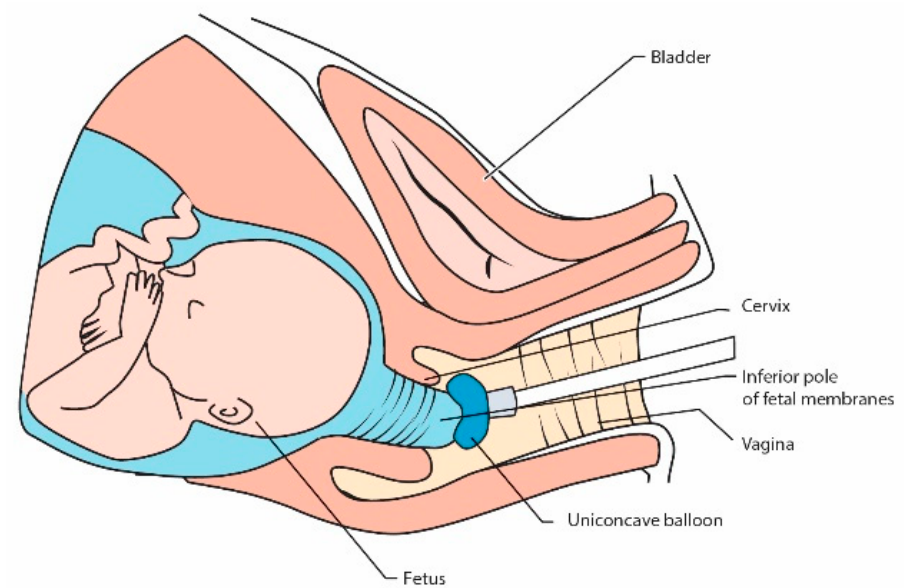
Figure 3. Using a uniconcave balloon device for repositioning fetal membranes into the uterus during emergency cerclage [63].